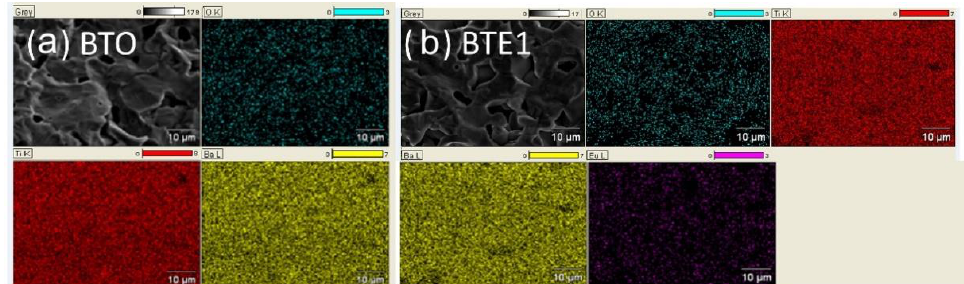
Figure 4. Surface analysis of the elemental composition. EPMA mappings for two selected samples: ( a ) BTO and ( b ) BTE1.